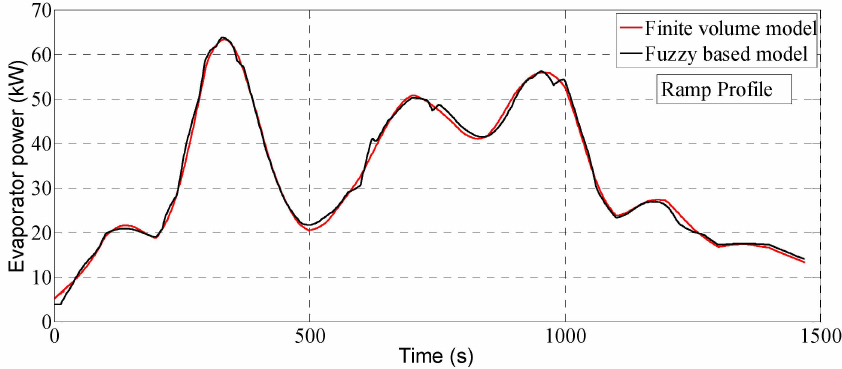
Figure 23. Prediction of the evaporator power with respect to ramp profile.